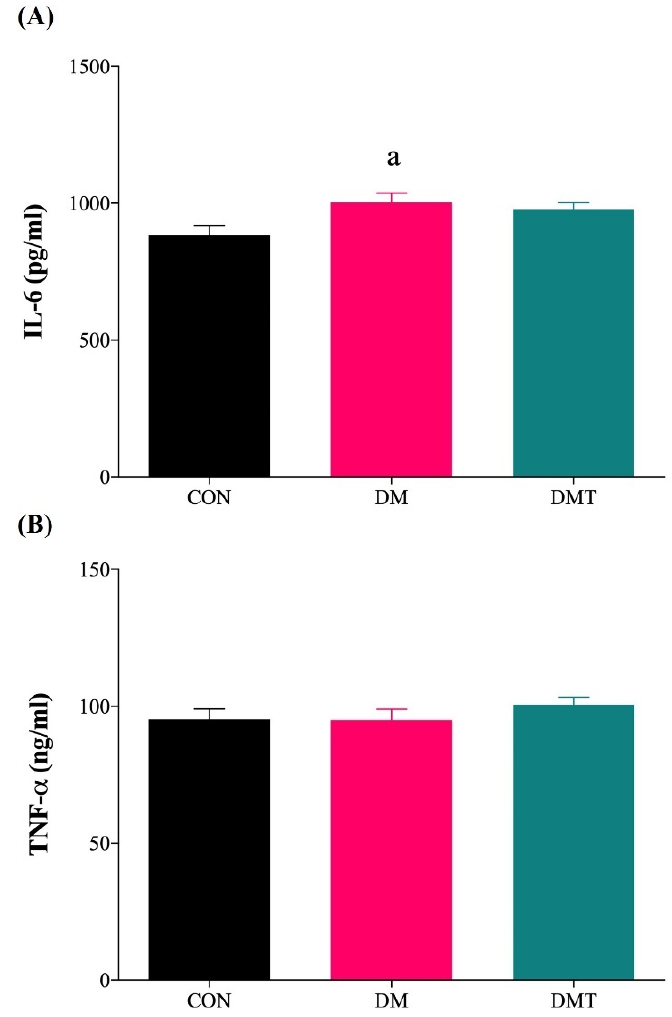
Figure 6. ( A ) IL-6 level and ( B ) TNF- α level in the aorta of experimental rats (n = 9). a p < 0.05 vs. CON. Abbreviation: CON; Control, DM; Diabetes, DMT; Diabetes receiving TUDCA, IL-6; Interleukin-6, and TNF- α ; Tumor Necrosis Factor-alpha .